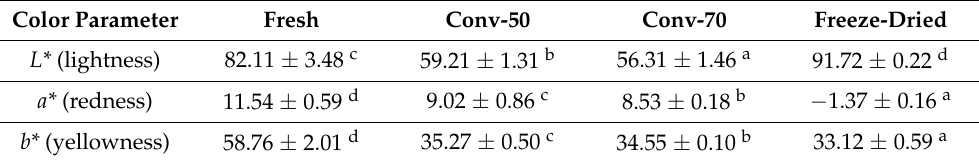
Table 2. Color parameters in L*a*b* space of fresh and dried